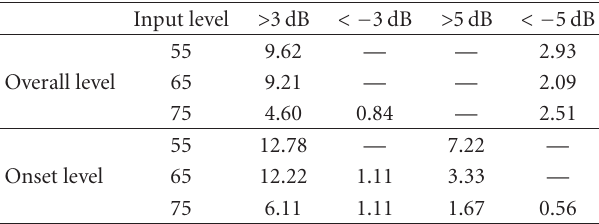
Table 6: Proportion of observations (%) showing di ff erences greater than 3 or 5dB (positive value indicates higher output levels of phoneme in running